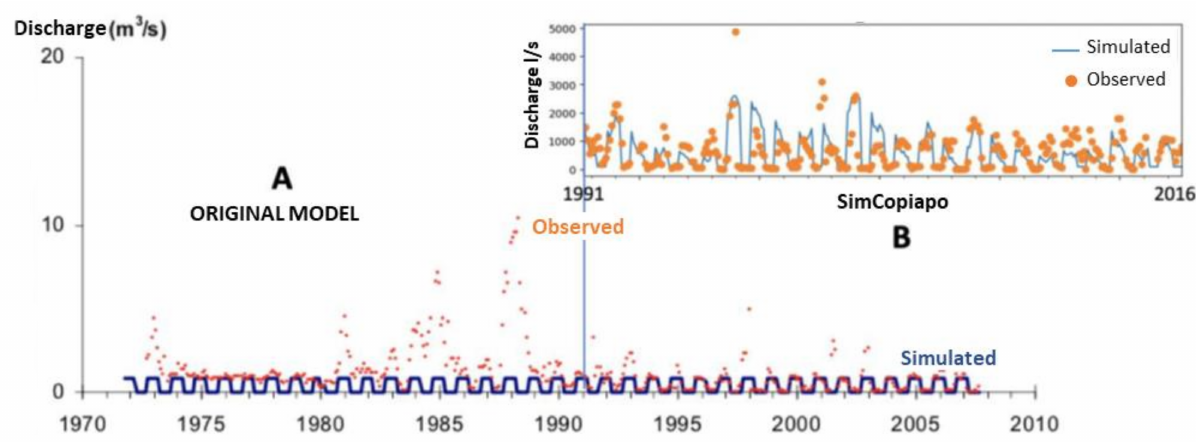
Figure 5. Release discharge from Lautaro Reservoir for the ( A ) original model developed by Hunter et al. [41] and Suarez et al. [40] and ( B ) adapted operational rule implemented in SimCopiapo.